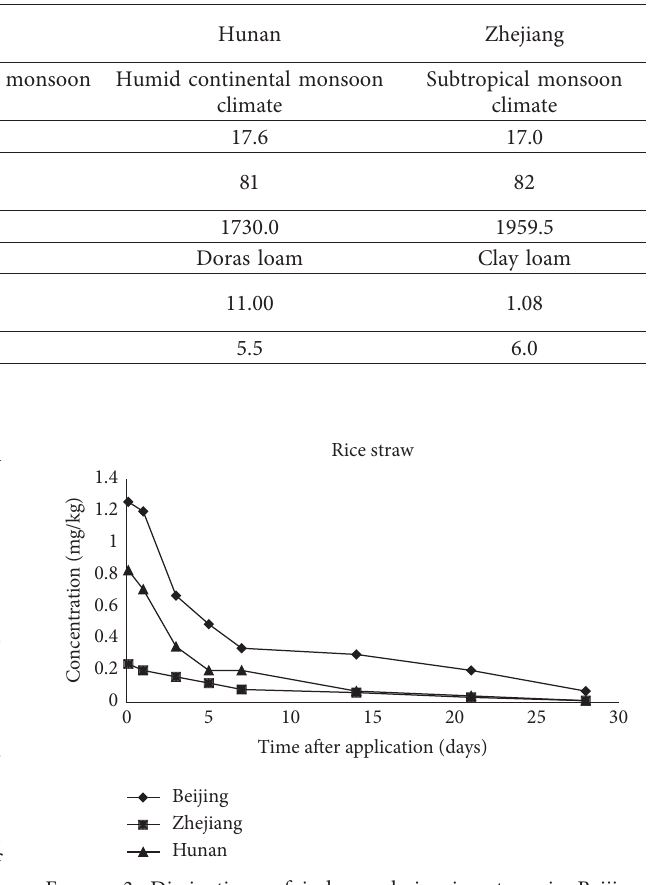
Figure 3: Dissipations of indoxacarb in rice straw in Beijing, Hunan, and